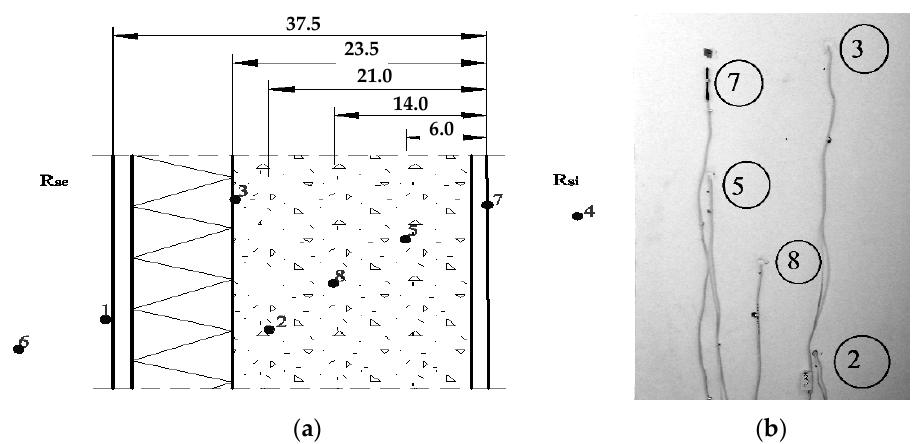
Figure 3. Placement of temperature sensors: ( a ) along the thickness of the enclosing structure (centimeters); ( b ) in the plane of the wall.